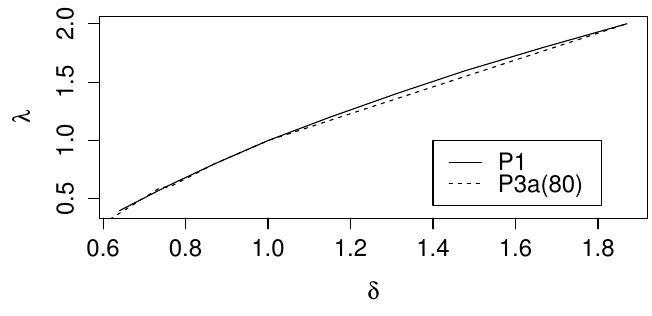
Figure 8. Offset effect: iso-premium